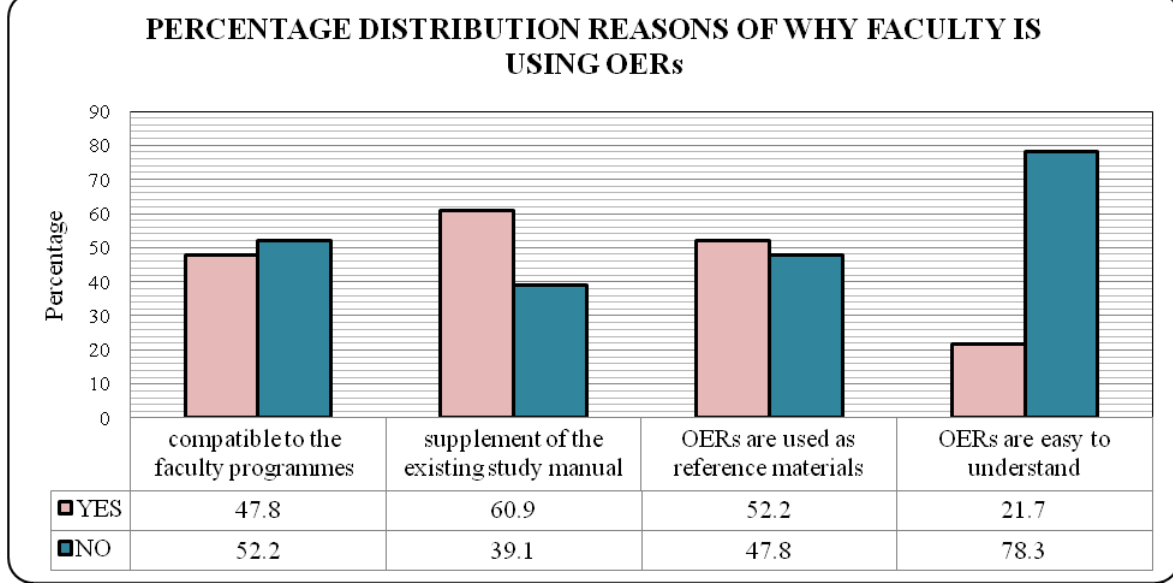
Figure 2. Why faculty use